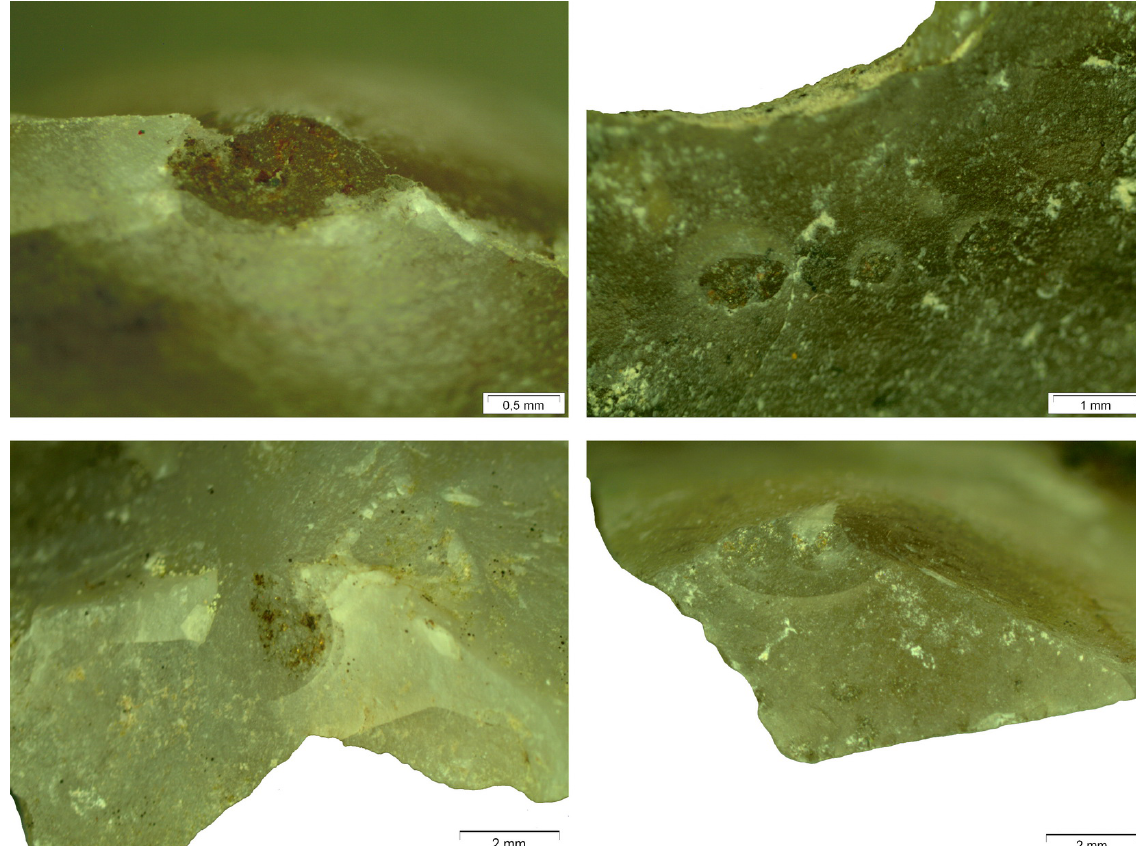
Figure 4. Flakes and blades butts with metal oxides and fissures caused by the use of a metallic hard hammer. (Scale bars: Top left - 0.5 mm; top right - 1 mm; bottom left - 2 mm; bottom right - 2